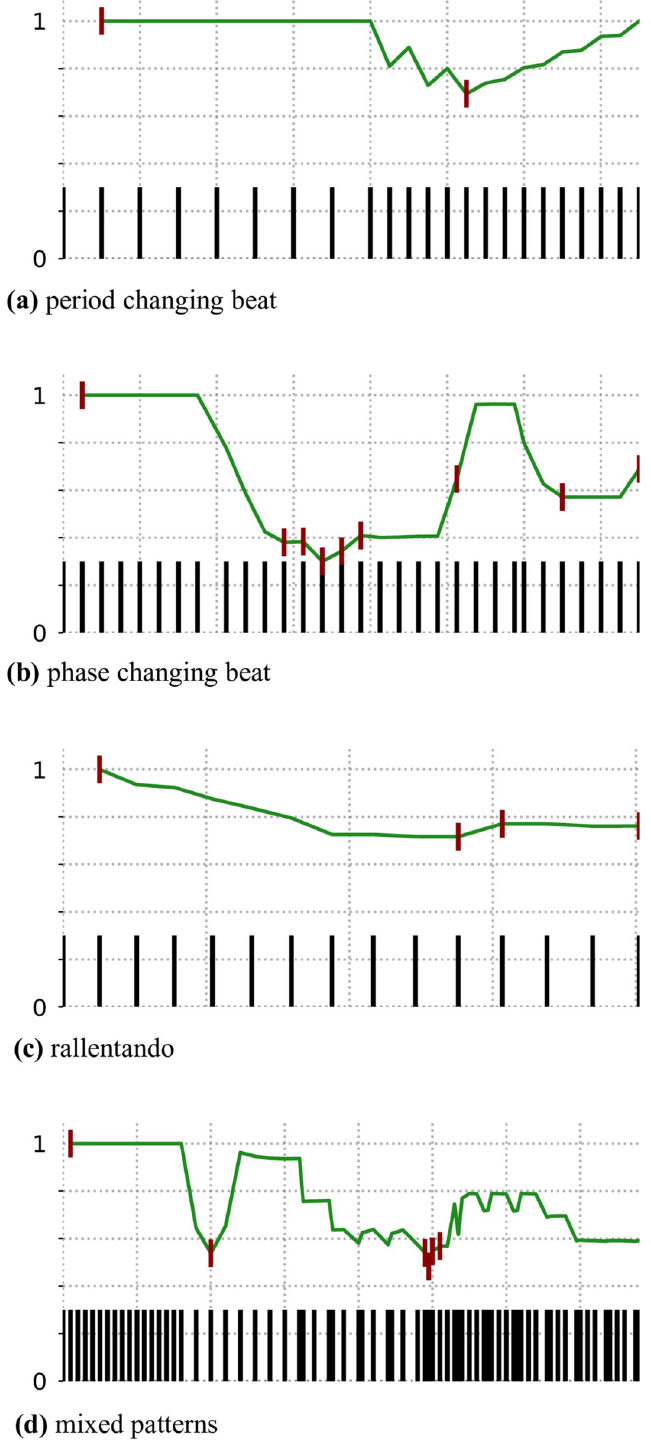
Fig 8. THT’s pulse clarity metric developing over synthetic rhythmic passages. The plots show the confidence of the top hypothesis over time. The X axis is time. The Y axis is the congruency score of the best hypothesis at a given time. Markers are placed each time the main hypothesis changes. At the bottom of the plot, the musical events are displayed over time.